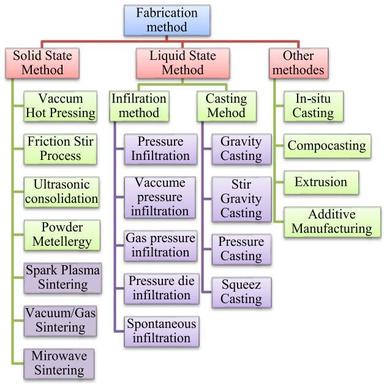
Fabrication methods of nitinol reinforced metal matrix composite.